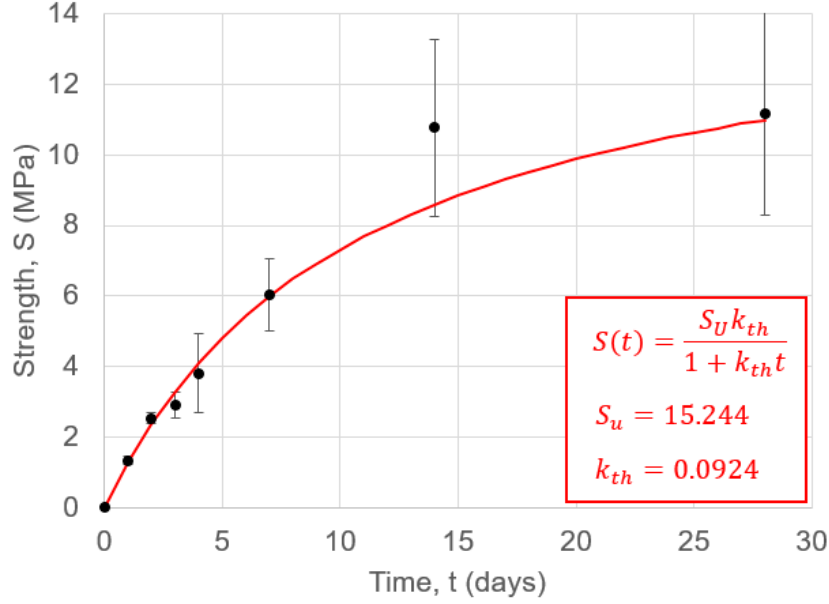
Figure 7. Compressive strength values for geopolymer cubes as a function of time. Error bars show the standard deviation, taken over three cube tests at each time point.